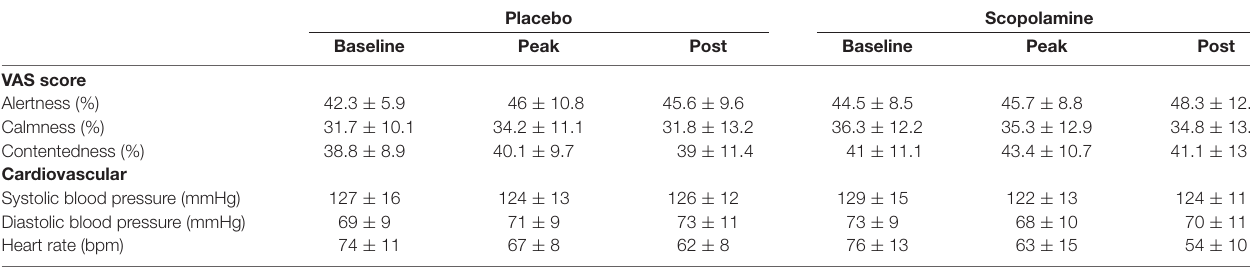
TABLE 1 | Side effect ratings from the scopolamine experiment.